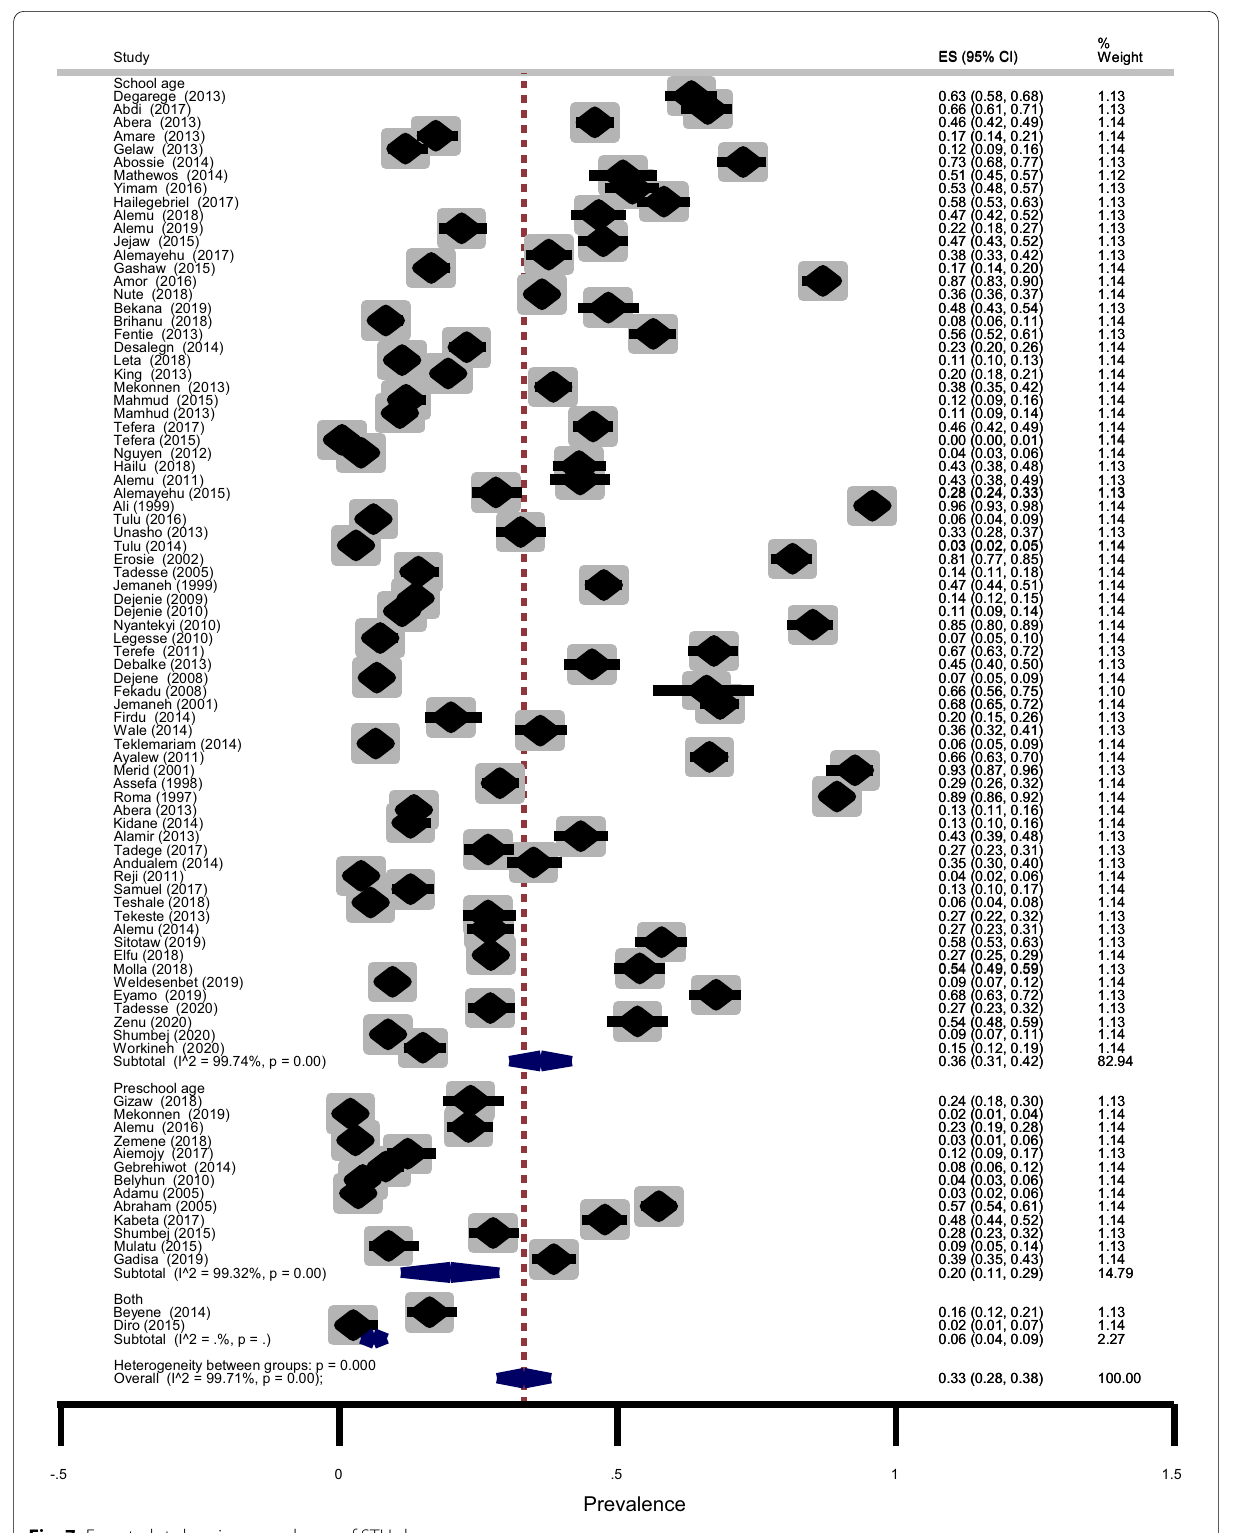
Fig. 7 Forest plot showing prevalence of STHs by